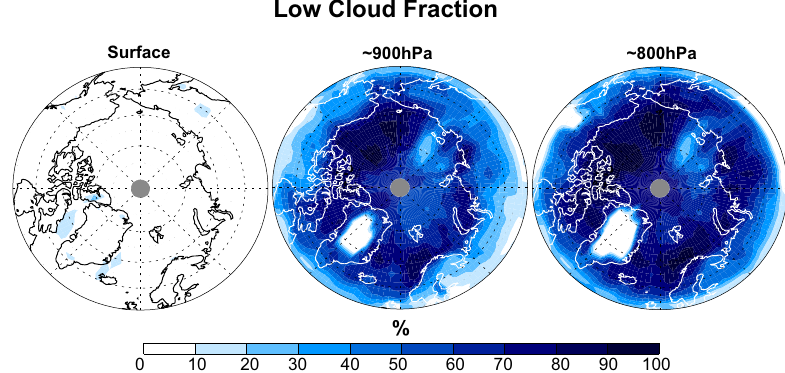
Figure 8. Low cloud fraction used in GLOMAP at the surface (0–50m), ∼ 900hPa (250–350m) and ∼ 800hPa (400–500m). Fig. 8. Low cloud fraction used in GLOMAP at the surface (0-50 m), ∼ 900 hPa (250-350 m) and ∼ 800 hPa (400-500 m).